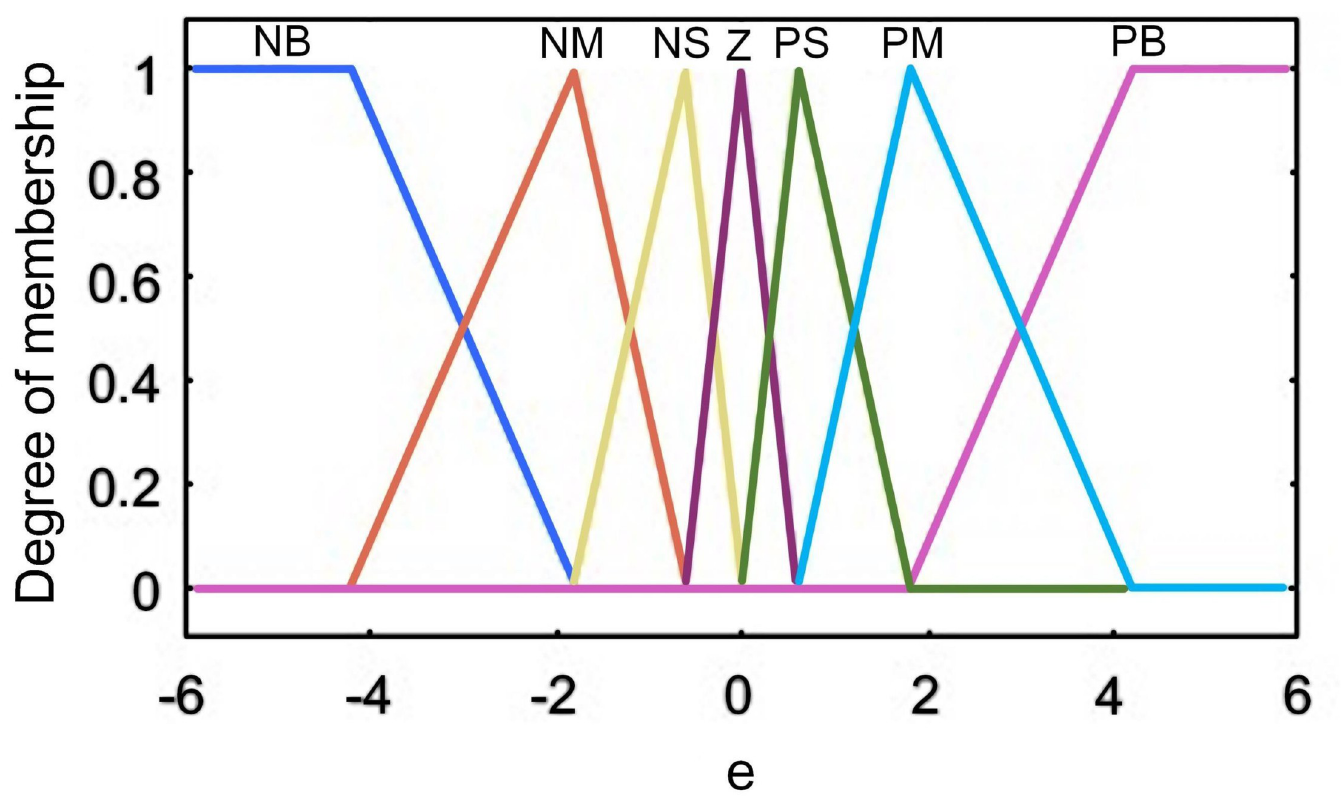
Fig 10. Affiliation function of polar slice correction bias e .